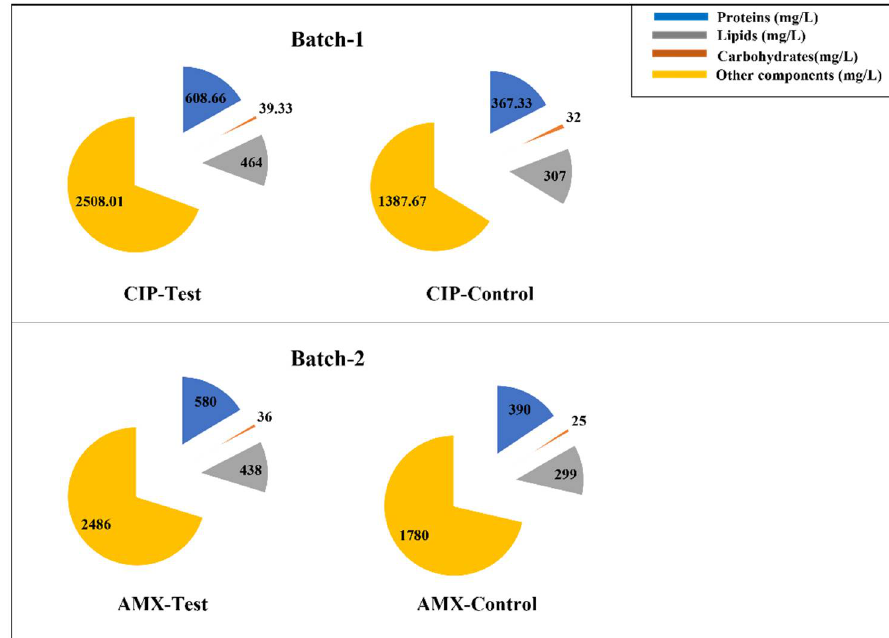
Figure 2. Effect of CIP and AMX upon lipid, carbohydrate, and protein accumulation in Chlorella vulgaris (incubation time = 7 days). vulgaris (incubation time = 7